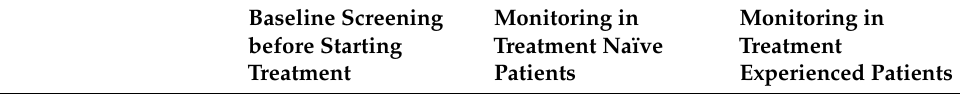
Table 4. HIV Specialists’ responses on testing